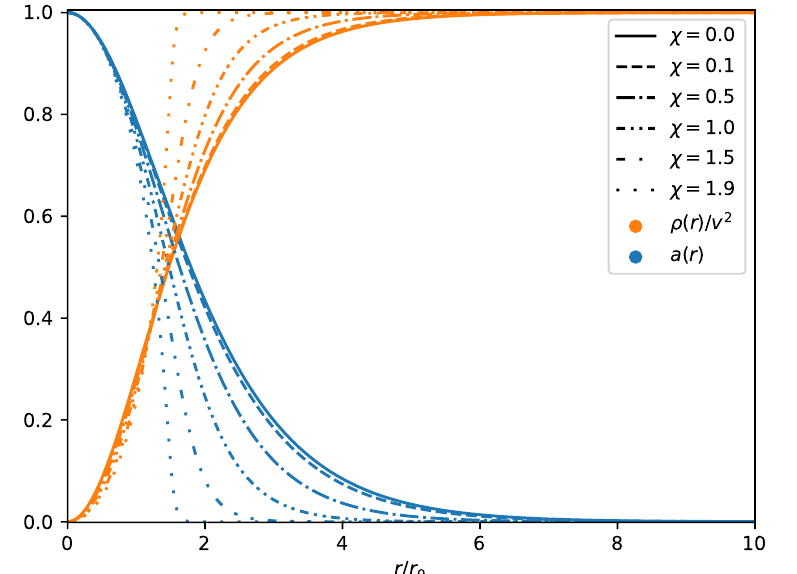
Figure 2 . Matter fields of the non-singular self-gravitating Abrikosov vortex of vorticity N = 1 for increasing values of the “strength of gravity” χ = 16 πGv 2 .